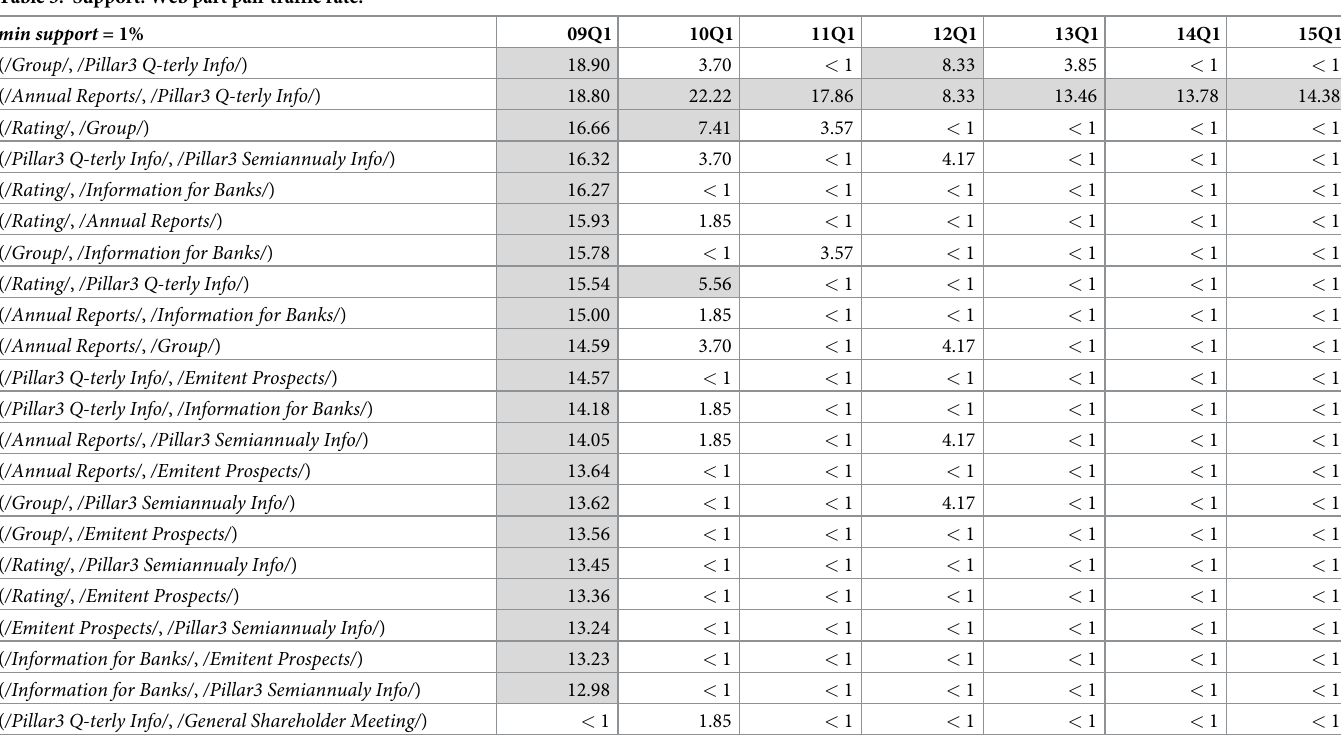
Table 3. Support: Web part pair traffic